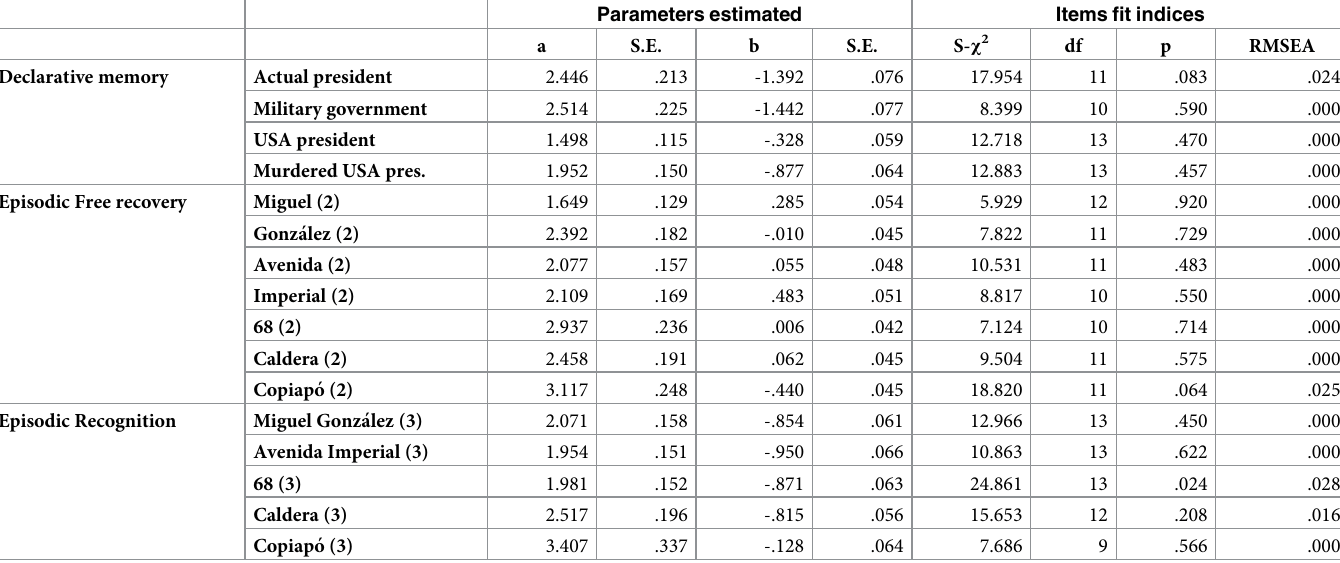
Table 5. Parameters estimated and item fit indices of proposed version of memory